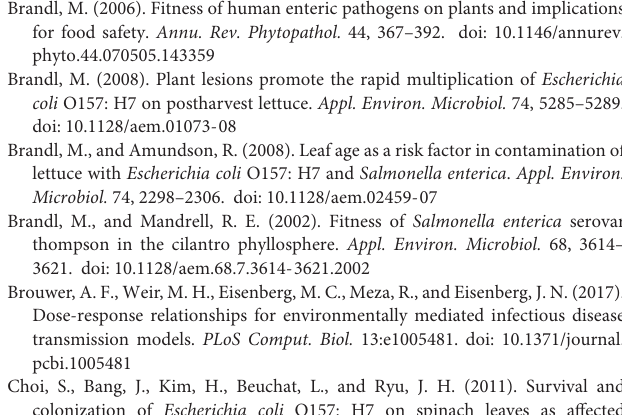
Supplementary Figure 1 | Methodology approach: Sampling, inoculation, and extraction of artificially added E. coli O157:H7 from individual spinach ( Spinacia